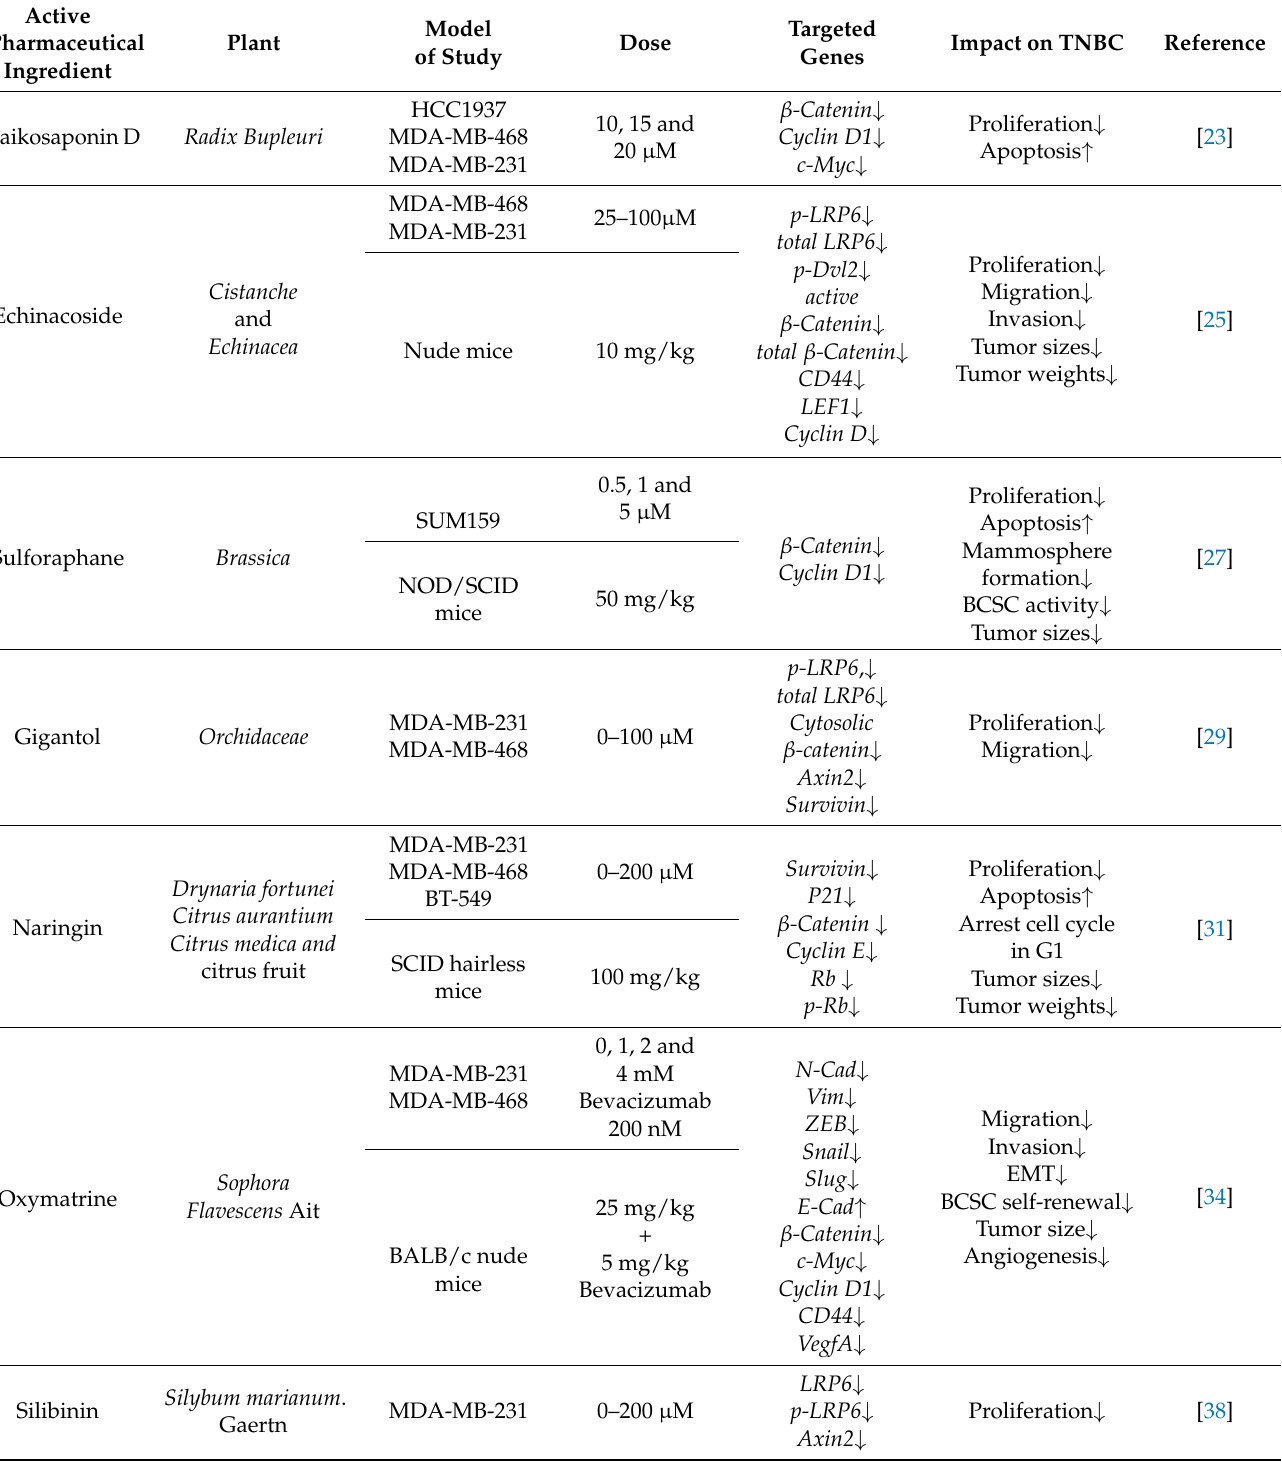
Table 1. Anticancer potentials of active phyto-therapeutic ingredients against triple negative breast